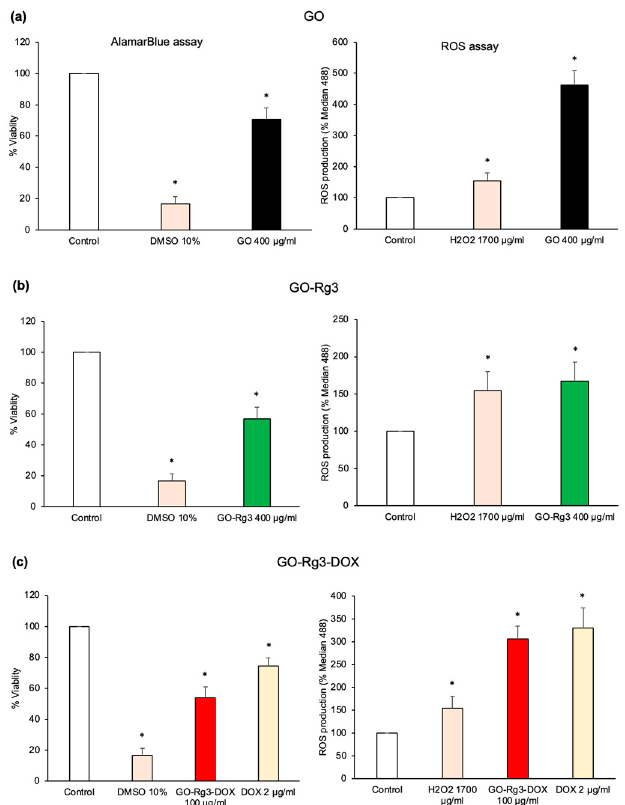
Figure 6. Rg3 and DOX cytotoxicity in human breast cancer MDA-MB-231 cells. ( a ) AlamarBlue assay 24 h after GO administration. All values were normalized to those obtained from untreated cells (medium only). The positive control was 10% DMSO. ( b ) AlamarBlue assay 24 h after GO–Rg3 administration. All values were normalized to those obtained from untreated cells (medium only). The positive control was 10% DMSO. ( c ) AlamarBlue assay 24 h after GO–Rg3–DOX administration. All values were normalized to those obtained from untreated cells (medium only). The positive